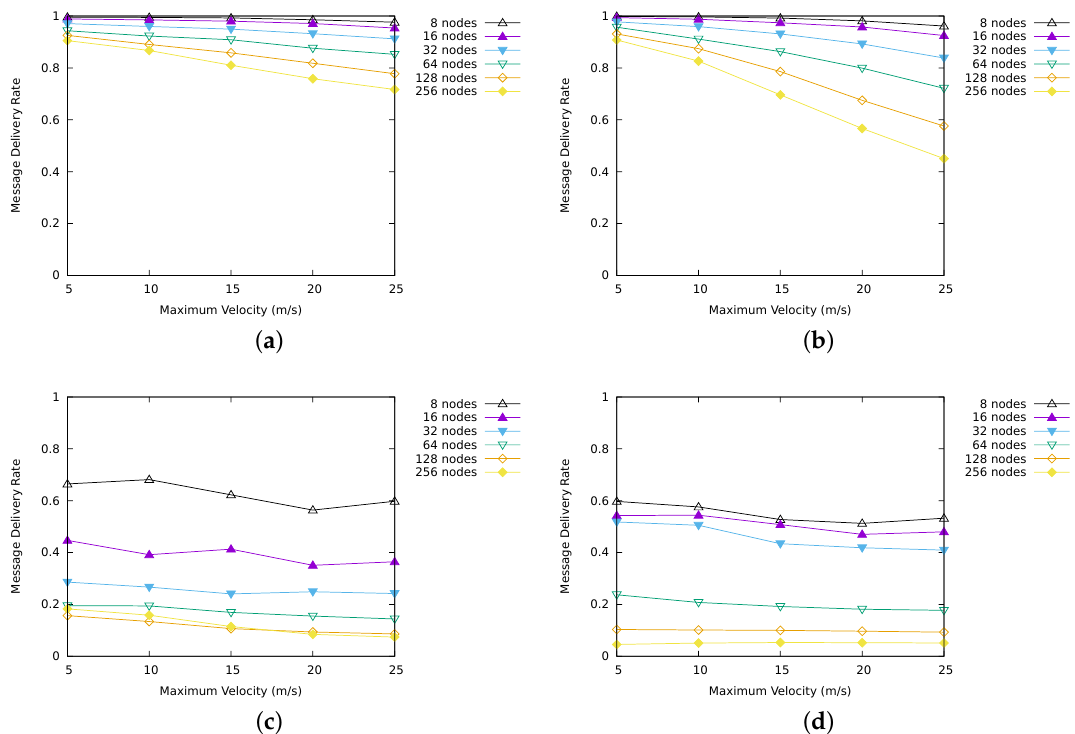
Figure 2. Message delivery rates for the simulated protocols. Results for a generation rate of four messages per node and second. ( a ) LBR1 message delivery rate; ( b ) LBR2 message delivery rate; ( c ) AODV message delivery rate; ( d ) RASeR message delivery rate.